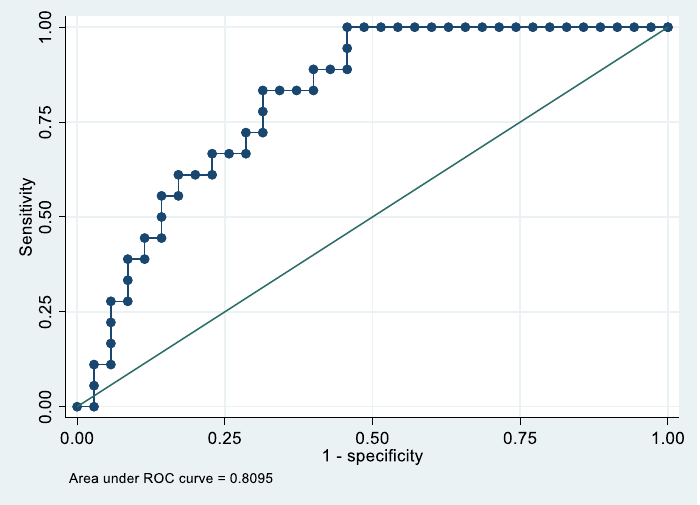
Figure 9. Receiver operating characteristics curve of the final model with the outcome Advanced Stage EC patients vs. controls.